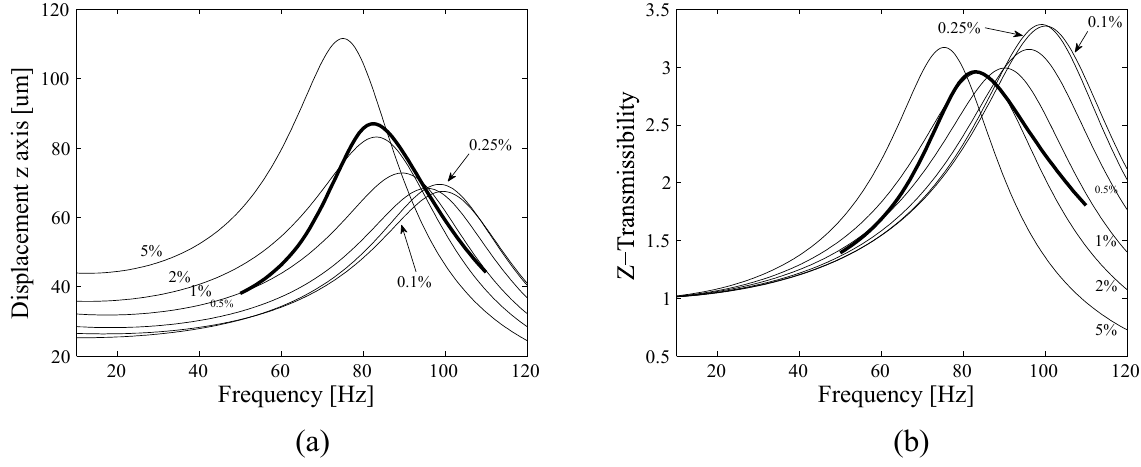
Fig. 5. (a) Displacement of concentrated mass(b) Force Transmissibility along z-axis Rz F : – homogeneous properties of rubber without amplitude – non linear procedure with amplitude dependency);